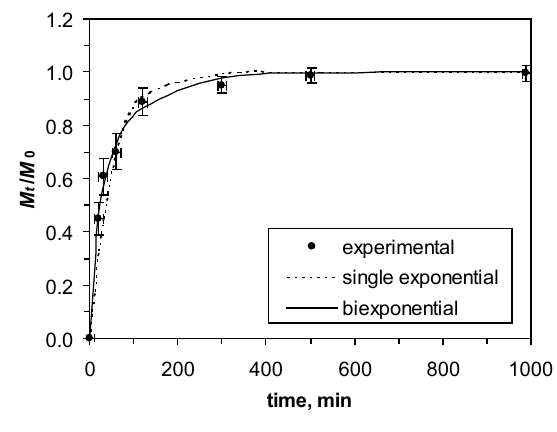
Figure 6. Experimental release kinetics of cephalexin (CPX) from CPX-PECA colloidal particles fitted with a single and biexponential functions. Experimental data are given with circles ( ● ), while the respective fits are given with dashed and solid lines as shown in the